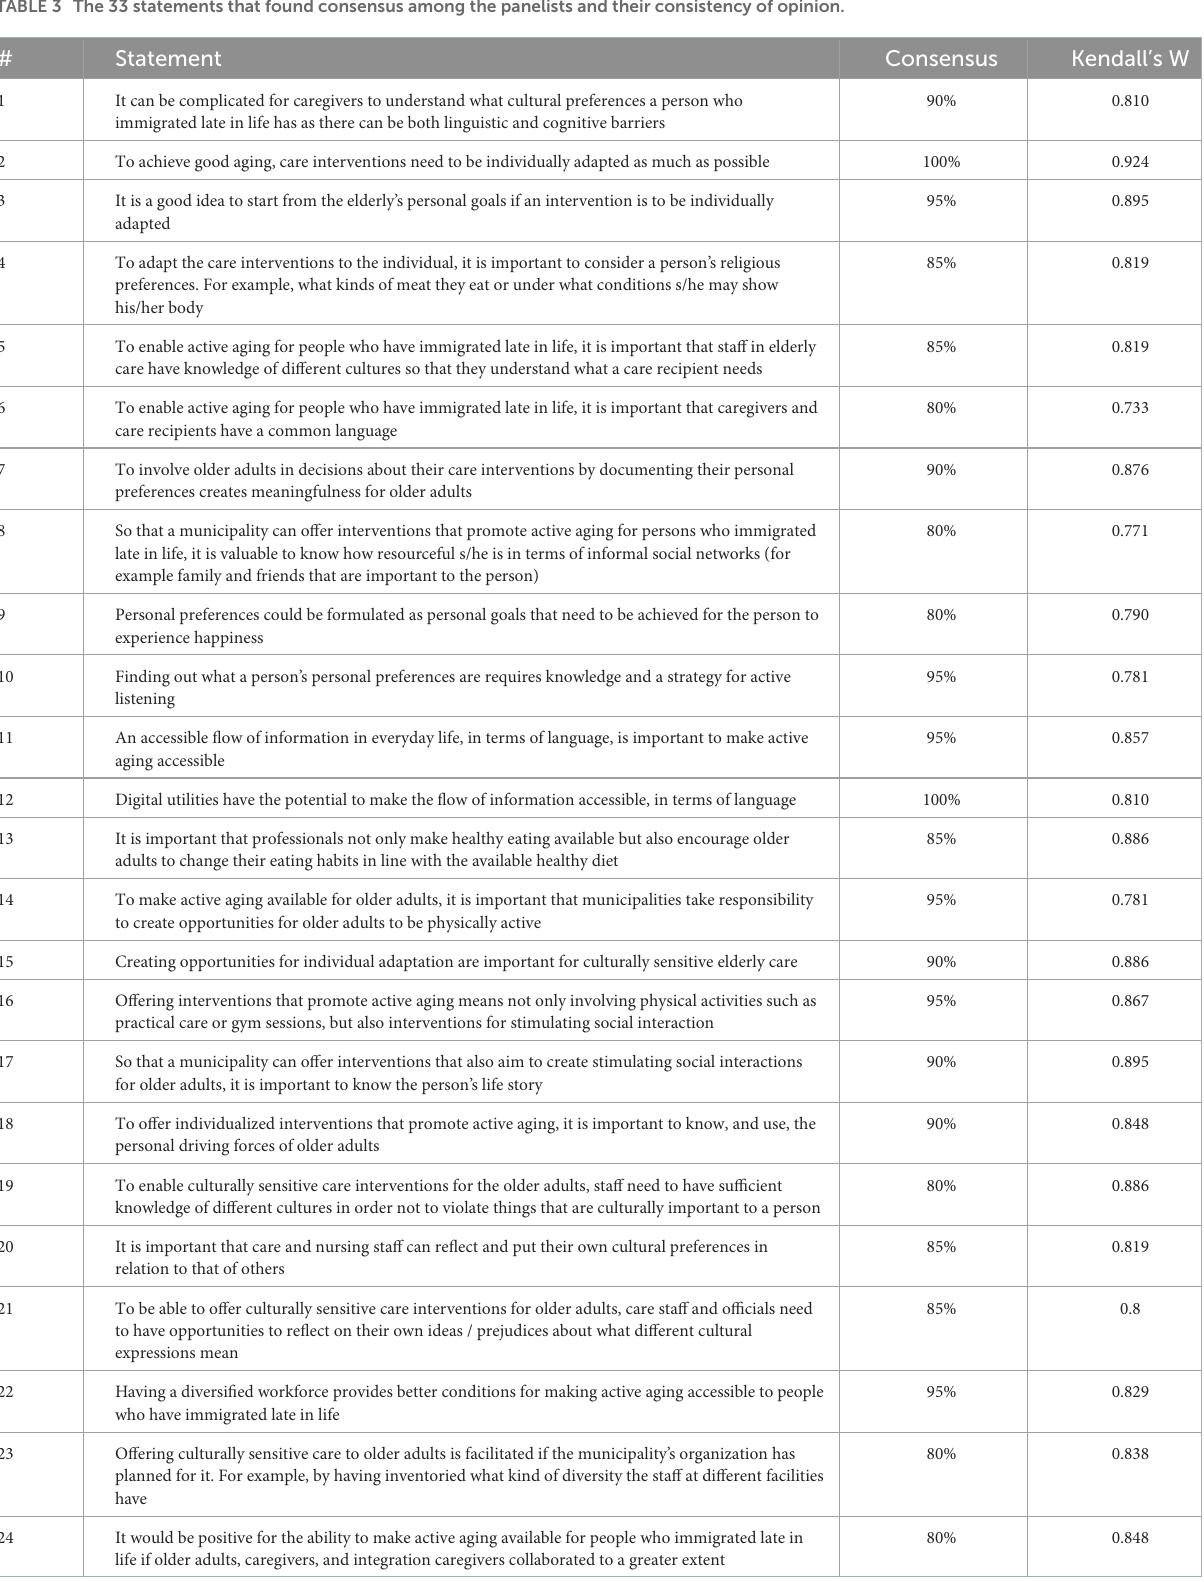
TABLE 3 The 33 statements that found consensus among the panelists and their consistency of